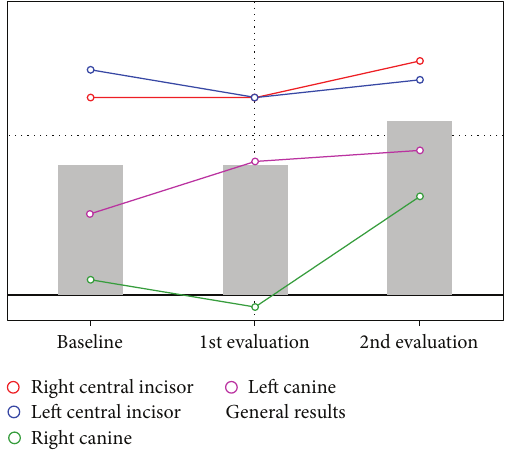
Figure 5: Overall result of